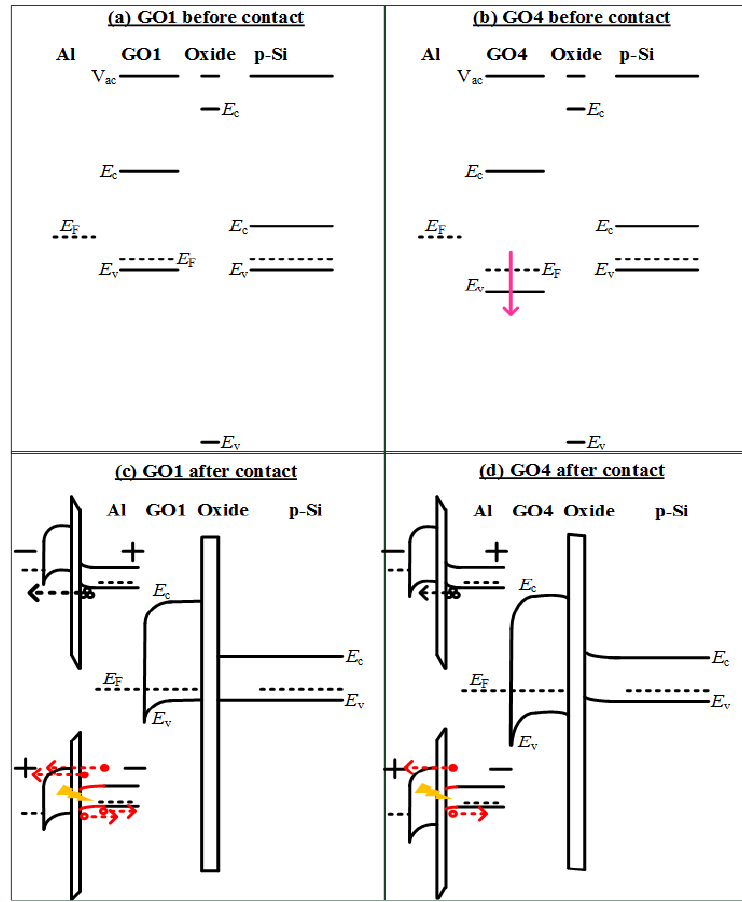
Figure 6. Band diagrams for ( a ) GO1 and ( b ) GO4 detectors on p-Si before and ( c ) GO1 and ( d ) GO4 detectors after contact. The larger work function of GO4 was detrimental to the formation of a depletion region in the p-Si.